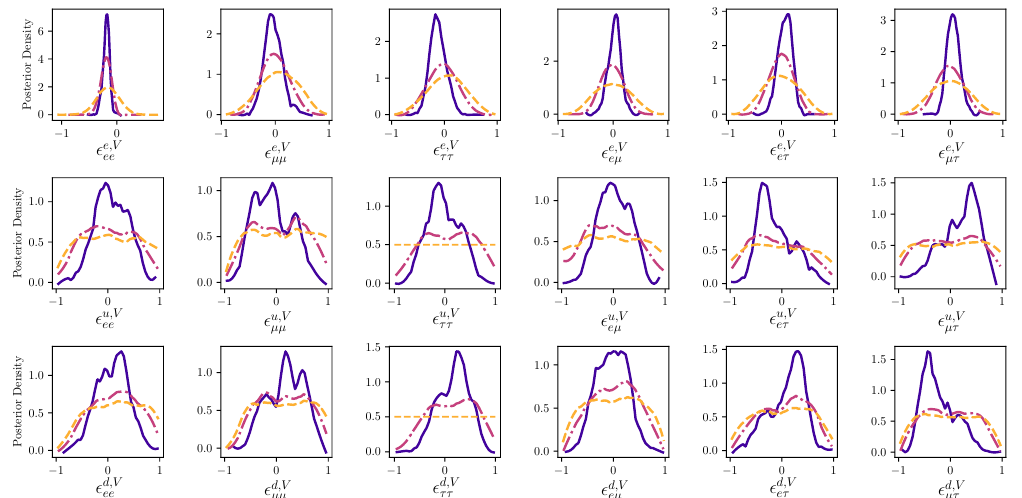
Figure 9 . Marginals of the posterior distributions in the prior (cid:13)ow as shown for the di(cid:11)erent stages in (cid:12)gure 3. The (cid:12)rst stage (dashed yellow) consists of COHERENT and Borexino. The second stage (dash-dotted magenta) consists of the future LXe projection for atmospheric neutrinos and solar neutrinos and takes in priors from the (cid:12)rst stage. The last stage (solid indigo) uses atmospheric neutrinos at DUNE and takes in priors from the second